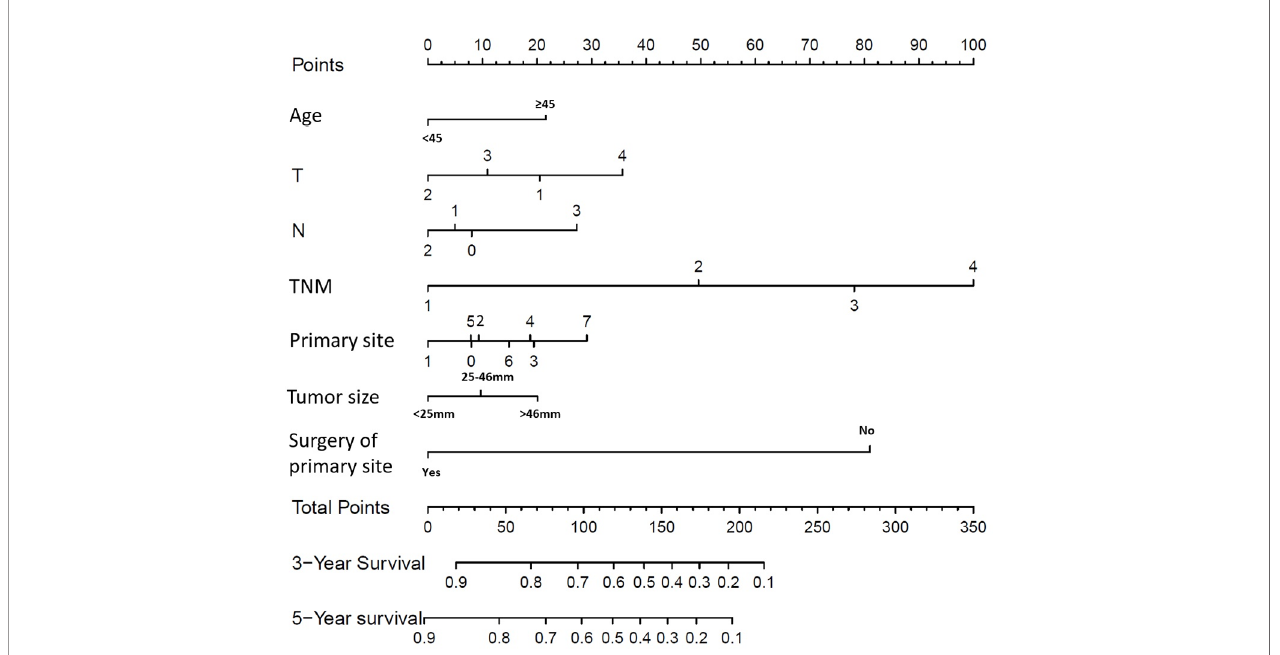
FIGURE 3 | Overall Survival (OS) nomograms for SRC patients at 3 and 5 years after diagnosis. For primary site: 0 represents cardia, NOS; 1 represents fundus of stomach; 2 represents body of stomach; 3 represents gastric antrum; 4 represents pylorus; 5 represents lesser curvature of stomach, NOS; 6 represents greater curvature of stomach, NOS; 7 represents overlapping lesion of